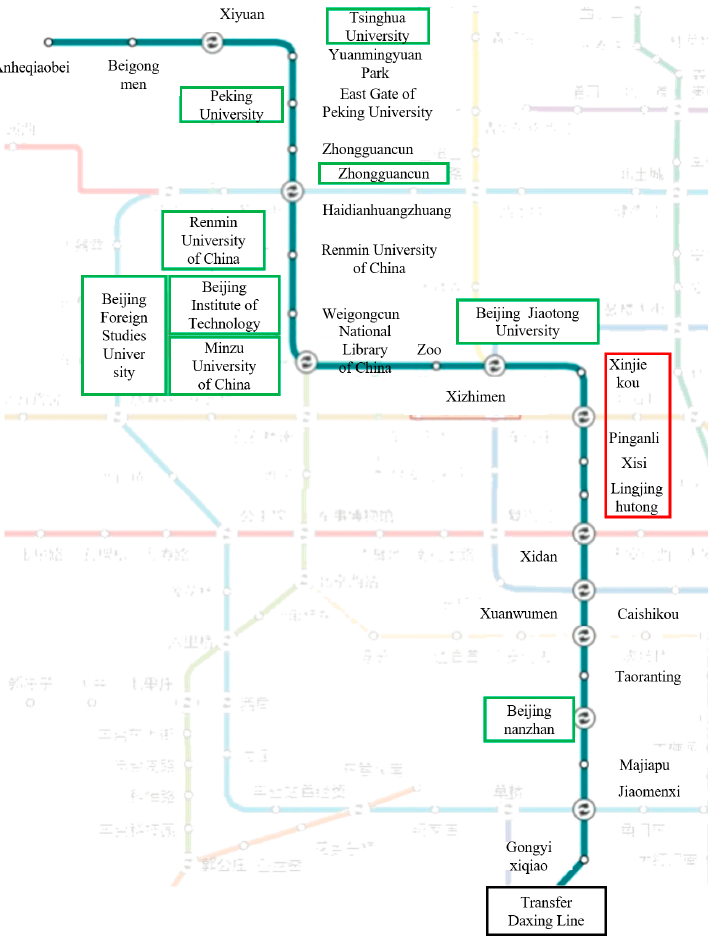
Figure 4. Illustration of Beijing Metro Line 4 (such as Xinjiekou, Pinganli, Xisi and Lingjinghutong) (Source: Baidu map).